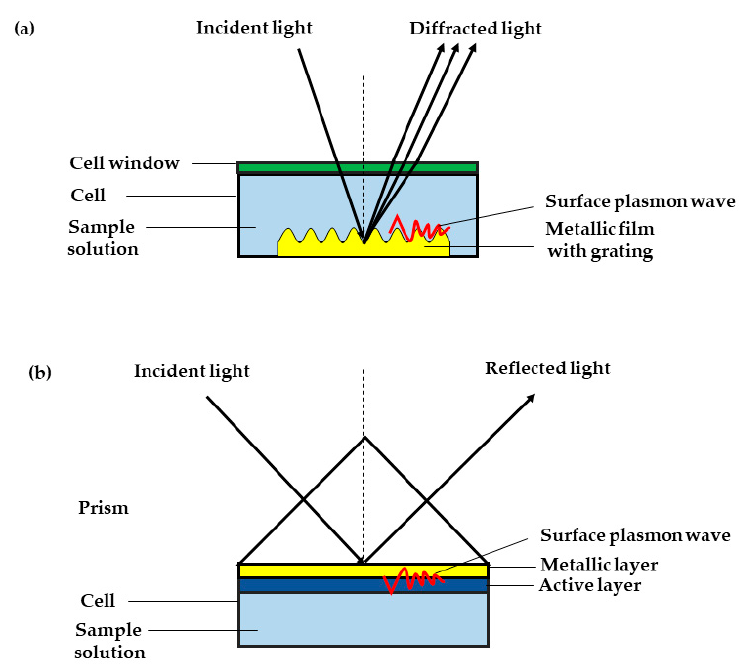
Figure 2. Surface plasmon resonance ( a ) grating-based and ( b ) prism-based (Kretschmann configuration).